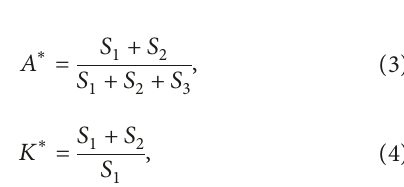
Figure 1: Epoxydized cottonseed oil/gluten and 2% zinc chloride heated at 20 ° C/min: TGA representation of S 1 , S 2 , and S 3